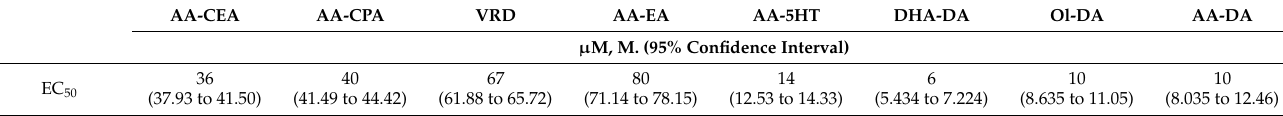
Table 1. The cytotoxicity of the synthesized fatty acid esters and ethers for the undifferentiated PC12 cells, 24 h incubation time, MTT assay, EC 50 values, lower value means higher cytotoxicity, mean with 95% confidence intervals, n = 5 experiments. AA-CPA, N-arachidonoyl cyclopropyamine, AA-CEA, N-arachidonoyl 2-chloroethylamine, VRD, virodhamine, AA-5HT, N-arachidonoyl serotonin, AA-EA, anandamide, AA-DA, N-arachidonoyl dopamine, DHA-DA, N-docosahexaenoyl dopamine, Ol-DA, N-oleoyl dopamine. AA-CEA AA-CPA VRD AA-EA AA-5HT DHA-DA Ol-DA AA-DA EC